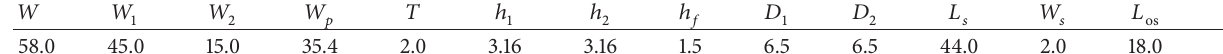
Table 1: Optimized dimensions of the proposed antenna (unit: mm).